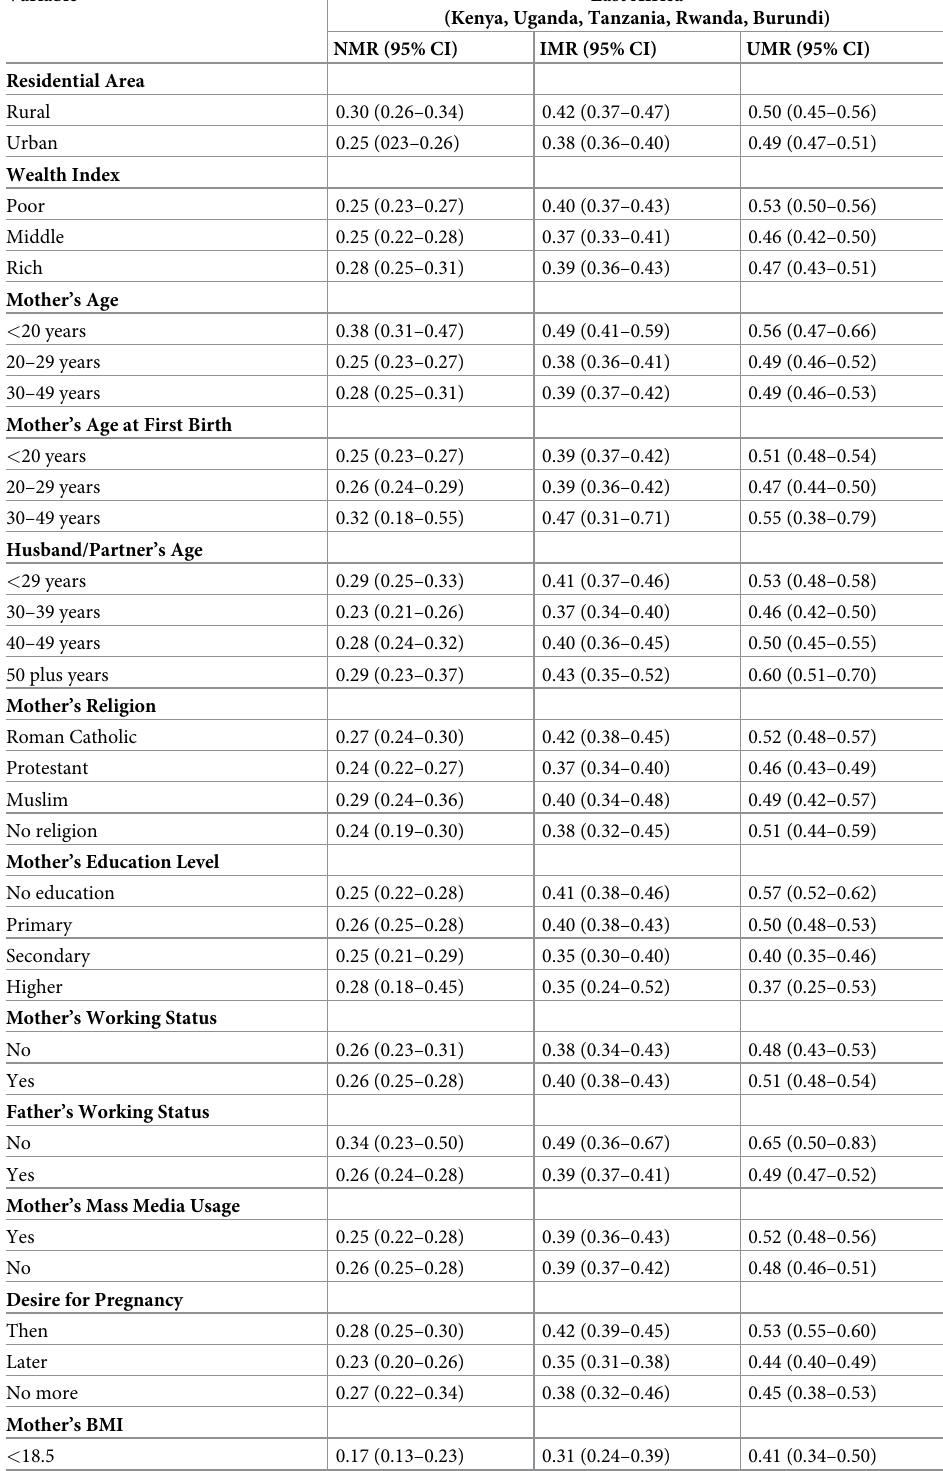
Table 4. Neonatal, infant and under-five mortality rates in East Africa (Per 1000 Births), by demographic charac- teristics of mothers.